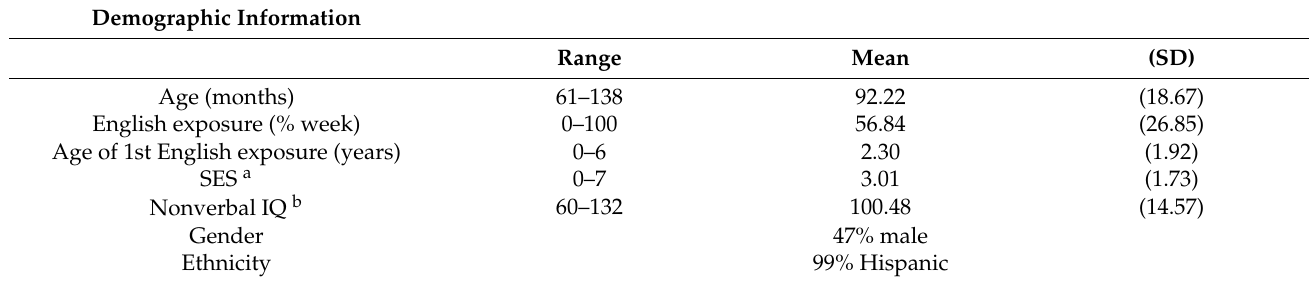
Table 1. Descriptive demographic